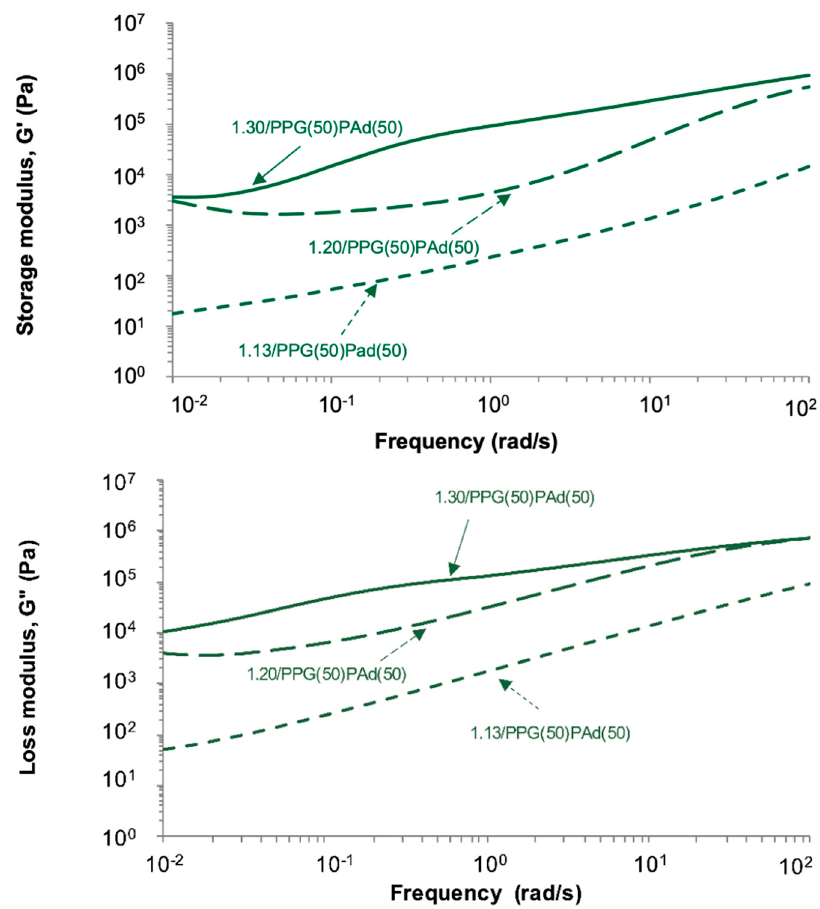
Figure 13. Variation of the storage (G ′ ) and loss (G ″ ) moduli as a function of the frequency of the TPUs synthesized with different NCO/OH ratios. Frequency sweep plate-plate rheology experiments.